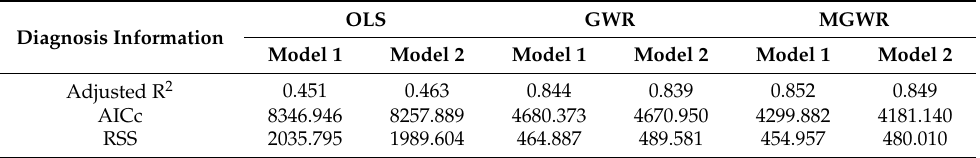
Table 3. Model diagnosis